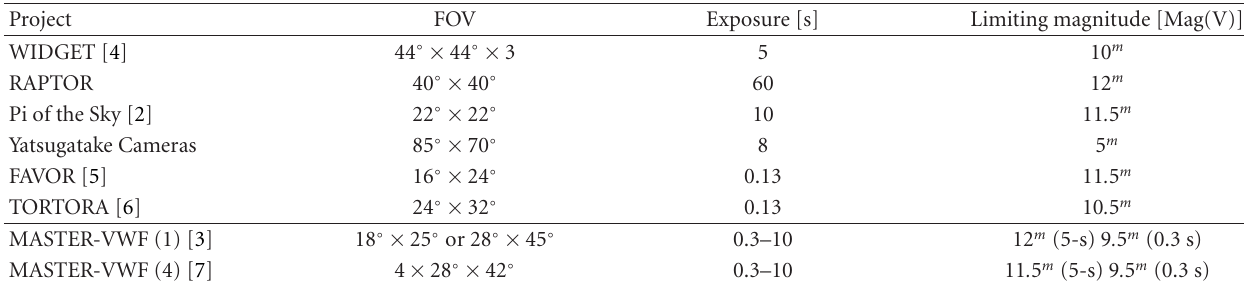
Table 1: Comparative characteristics of super Wide-Field